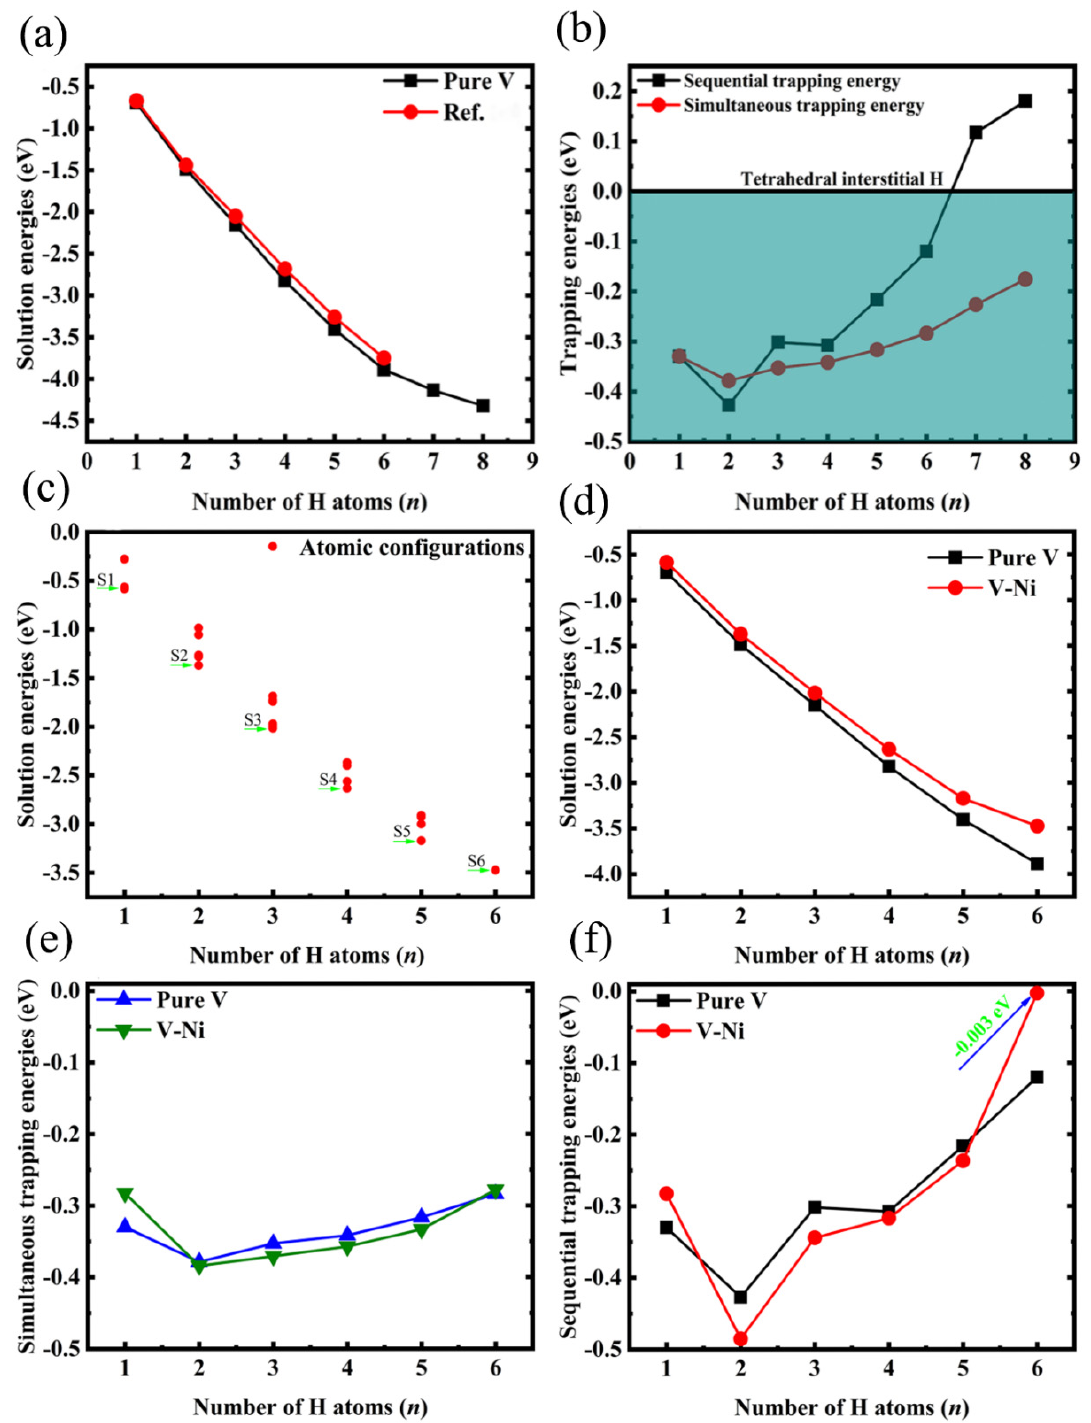
Figure 6. ( a , c , d ) Solution energies and ( b , e , f ) trapping energies of multiple H atoms in a monovacancy of V and V–Ni alloy. Reference data are obtained from Pengbo et al. [13].